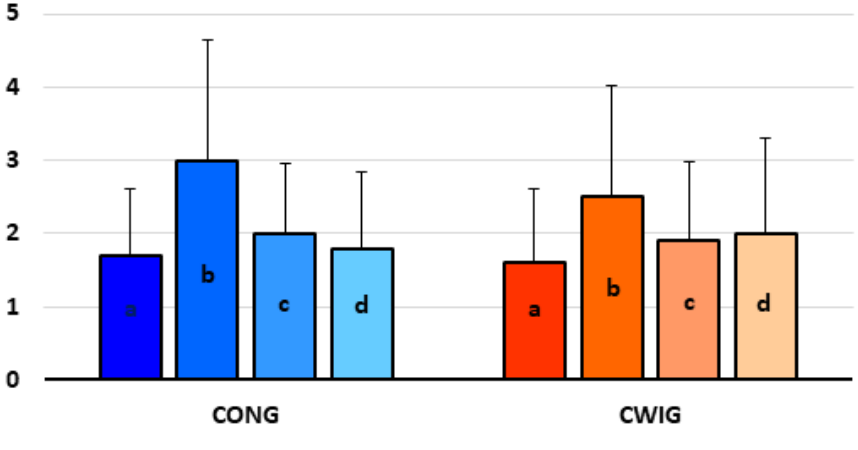
Figure 4. Change in SOD concentration after CWI. (Data are expressed as mean ± standard deviation. A main effect was evident with respect to time - p < 0 .001. CWI: cold-water